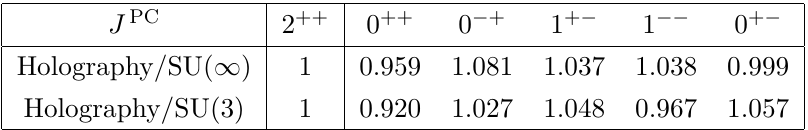
5 . Ratios of glueball masses measured in the units of the 2 ++ mass, ( m J PC /m 2 ++ ) / ( m J PC /m 2 ++ ) , for holographic (Klebanov-Strassler) and lattice predictions for hol hol latt latt